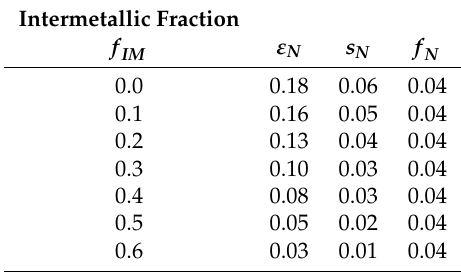
Table 5. Parameters of the Gurson–Tvergaard–Needleman (GTN) nucleation model for increasing volume fraction of intermetallic